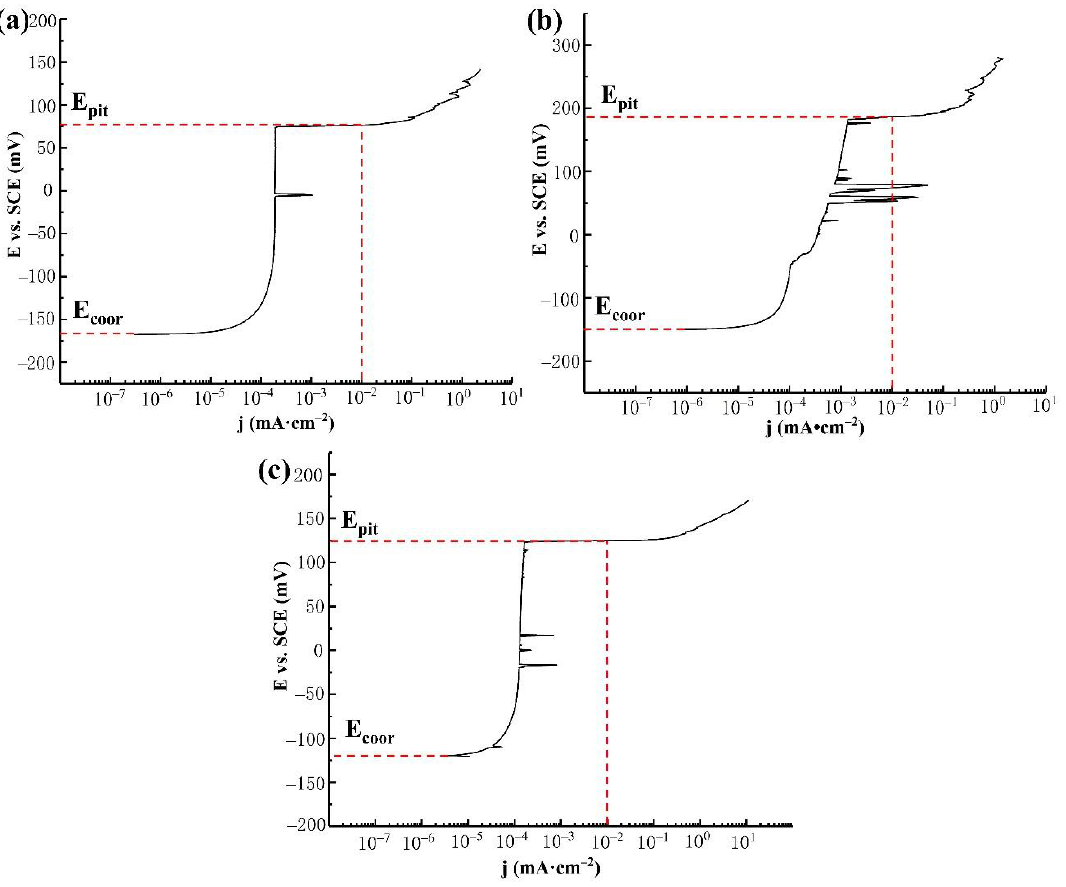
Figure 14. Polarization curve of the WM for all samples: ( a ) without ultrasonic treatment, ( b ) with ultrasonic treatment and ( c ) base metal. Table 5. Values of the pitting corrosion indexes of the WM for all samples.